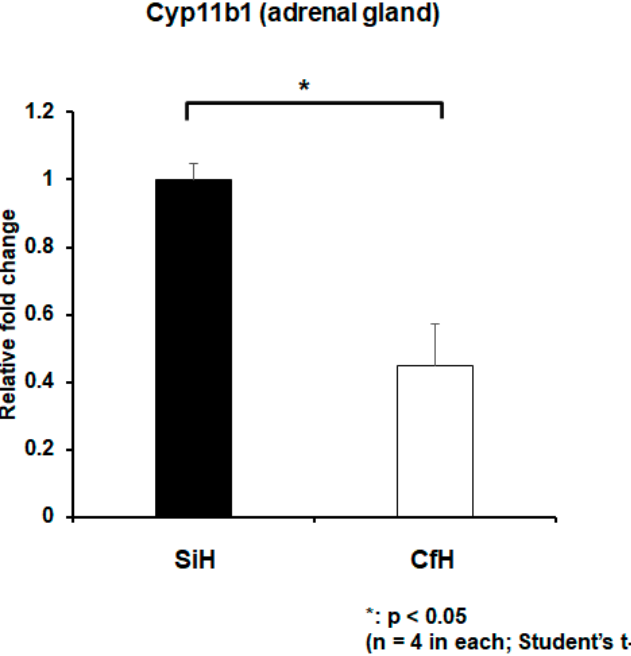
Figure 1. Gene expression of CYP11B1 in the adrenal gland. *: p < 0.05 vs. the SiH group (Student’s t -test).